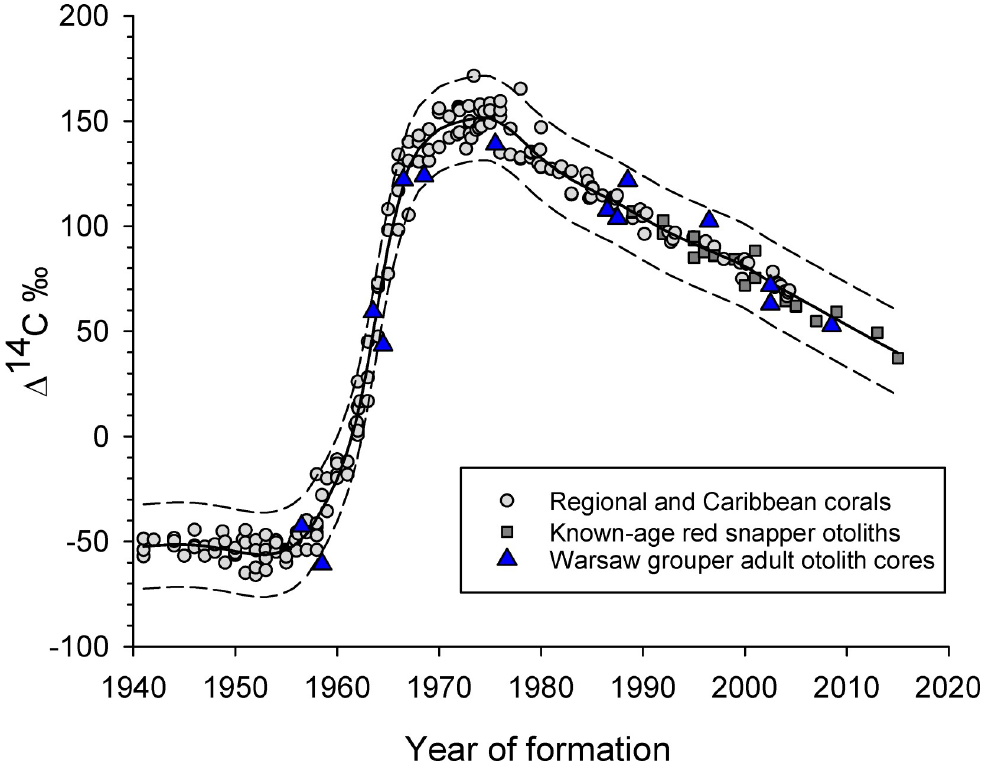
Fig 3. Regional coral and known-age otolith Δ 14 C values versus year of formation with Warsaw grouper otolith core Δ 14 C values overlain on plot. Scatterplot of regional coral and known-age red snapper Lutjanus campechanus otolith Δ 14 C values versus year of formation, with Warsaw grouper otolith core Δ 14 C data overlain on the plot. A loess regression (degree = 2; α = 0.20) fit to the coral and known-age red snapper otolith Δ 14 C values is shown as a solid line. Dashed lines are Bonferroni-corrected 95% confidence intervals. Warsaw grouper birth year was estimated as sample collection year minus otolith opaque zone